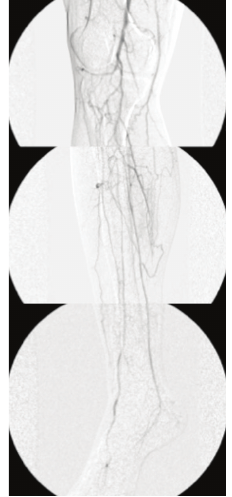
Figure 1: Case 1: preoperative arteriography showed that the bilateral iliac, femoral, and popliteal arteries were intact, but the bilateral posterior tibial arteries were occluded.